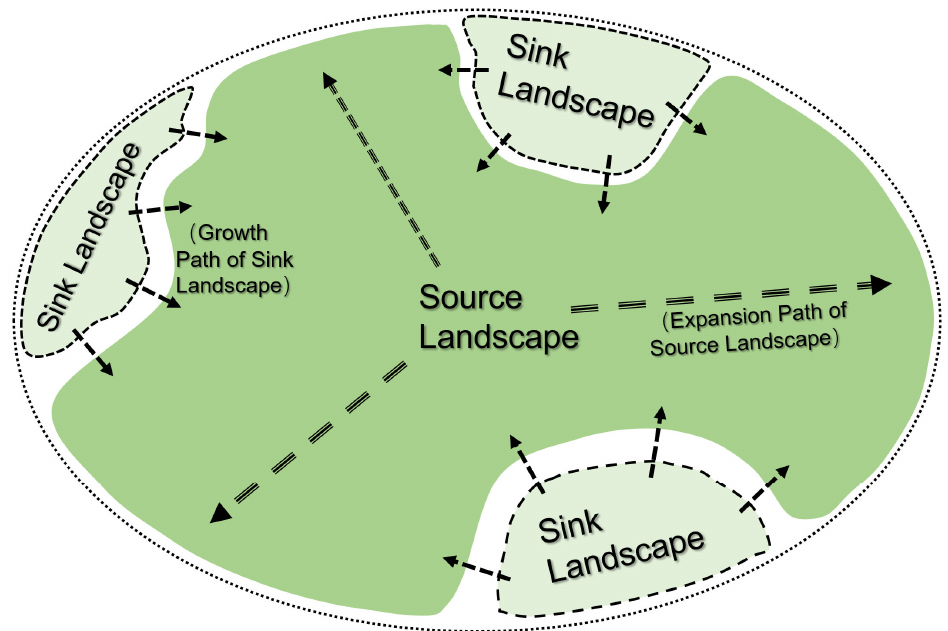
Figure 3. The schematic diagram of the source–sink landscape theory.